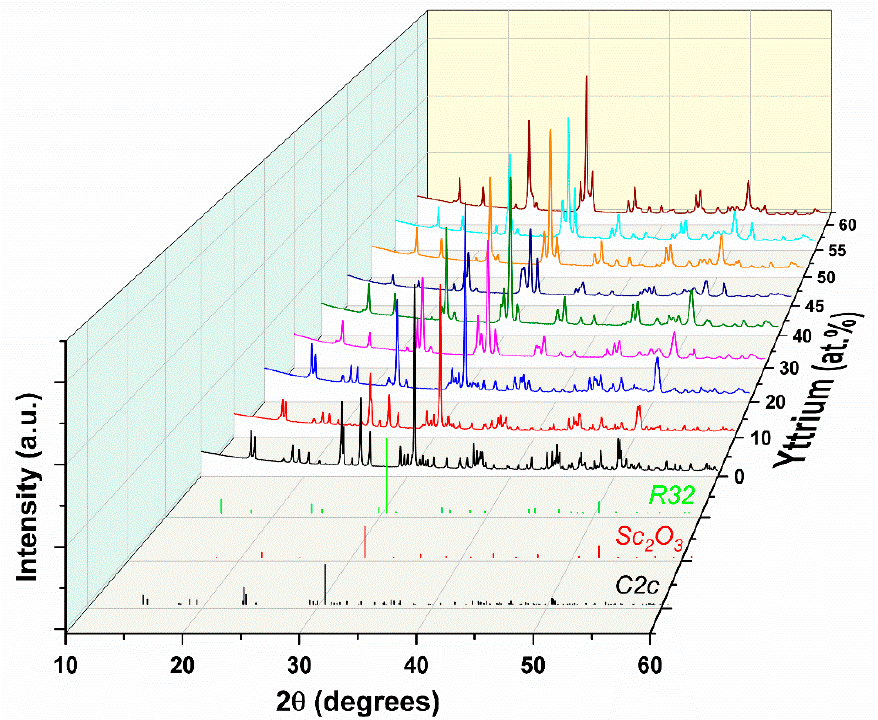
Figure 1. Room ‐ temperature XRPD spectra of La 1 ‐ x Y x Sc 3 (BO 3 ) 4 polycrystalline compounds. The vertical bars in black, red, and green are associated with PDF card 01 ‐ 087 ‐ 1665 of C2/c monoclinic phase, PDF card 04 ‐ 001 ‐ 2439 of cubic Sc 2 O 3 phase, and PDF card 04 ‐ 018 ‐ 1225 of R32 trigonal phase, respectively. (Adapted with permission from ref. [13], copyright 2019 American Chemical Society).